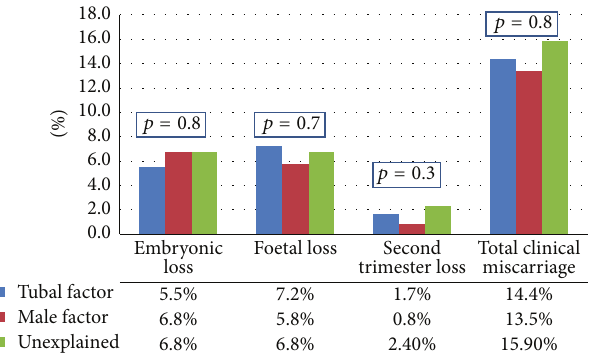
Figure 3: A comparison of the rates of pregnancy loss in tubal, male, and unexplained infertility.